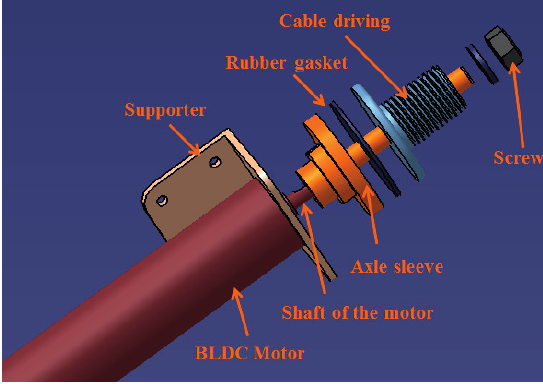
Figure 6. Design of the exoskeleton device (elbow joint).